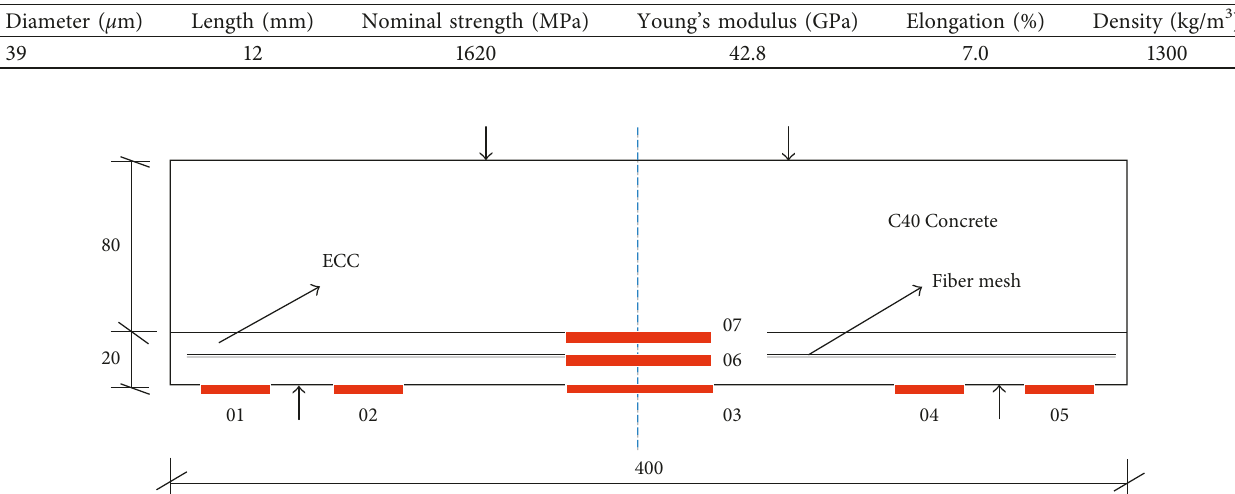
Table 2: Characteristics of PVA fiber.